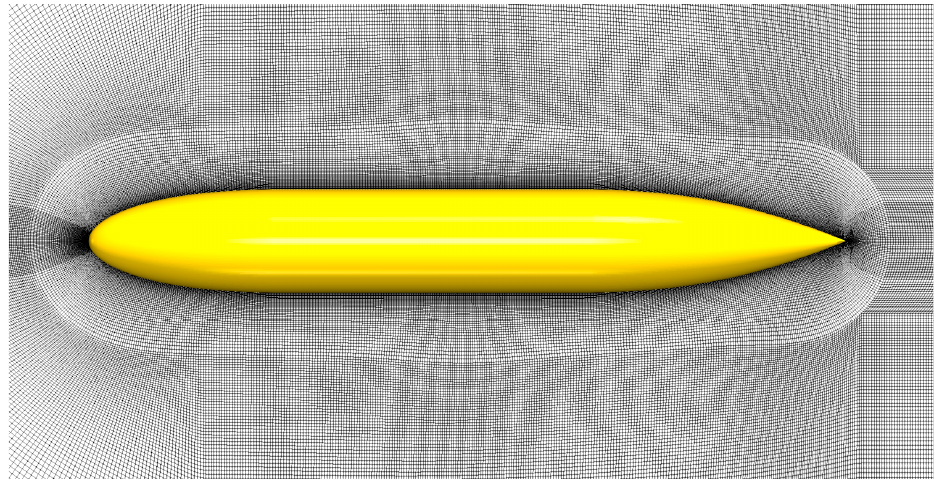
Figure 9. View of computational mesh around Joubert model submarine hull used in the validation